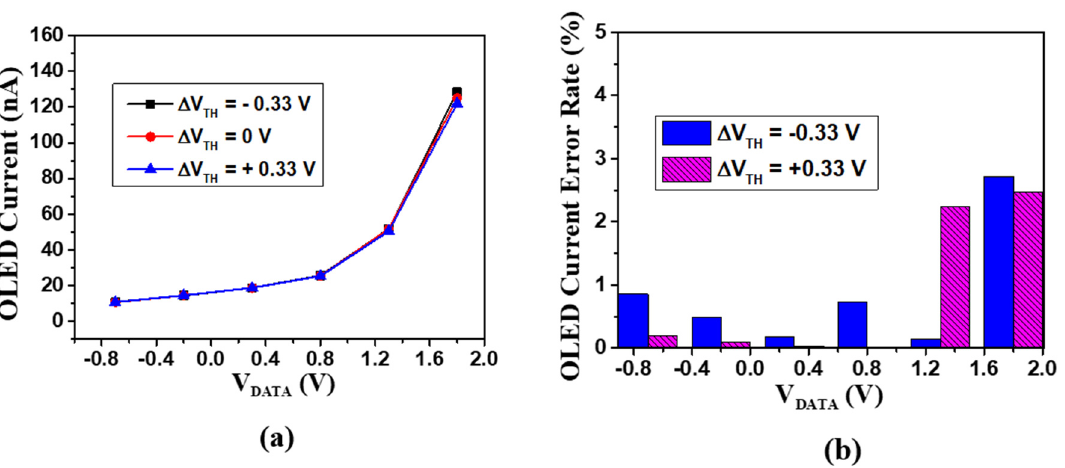
Figure 5. ( a ) OLED currents versus data voltage with ± 0.33 V variation in V TH_DTFT . ( b ) OLED current error rates with ± 0.33 V variation in V TH_DTFT .